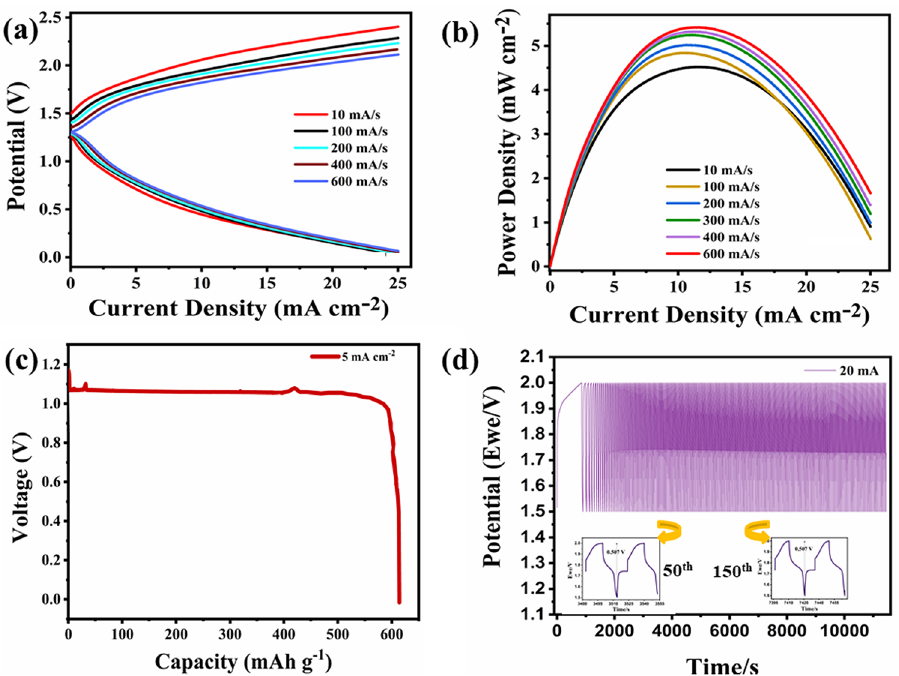
Figure 7. Performance of fabricated solid-state ZAB. ( a ) Charge/discharge of the cell at various scan rates; ( b ) CCTO power density; ( c ) CCTO discharge profile (capacity vs. potential) at 5 mA cm -2 ; ( d ) Chronopotentiometric charge/discharge cycles for CCTO at 20 mA with the potential range of 1.5–2.0 V, (insight: shows charge/discharge potential